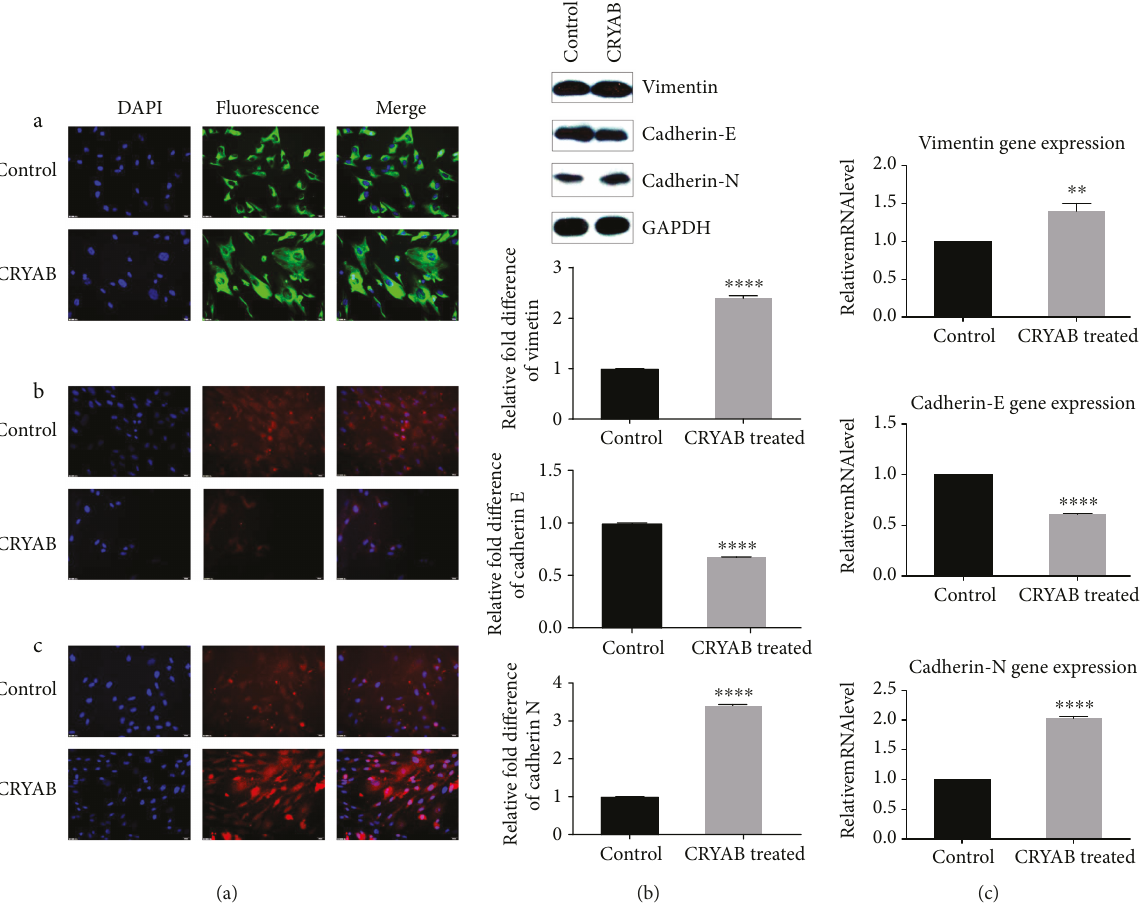
Figure 5: E ff ect of CRYAB on EMT in TM cells. (a) Immuno fl uorescence manifestation of vimentin, cadherin-E, and cadherin-N. Immuno fl uorescence veri fi ed the upregulation of vimentin and cadherin-N and the downregulation of cadherin-E (A: vimentin; B: cadherin-E; C: cadherin-N). (b) Western blot analysis of vimentin, cadherin-E, and cadherin-N expression. TM cells were exposed to 10ng/ml CRYAB for 24h. The expression of vimentin and cadherin-N increased, whereas cadherin-E decreased under CRYAB conditions compared with the control. (c) Real-time PCR analysis of vimentin, cadherin-E, and cadherin-N mRNA expression. Compared with the control, the expression of vimentin and cadherin-N was upregulated, while cadherin-E was downregulated in response to CRYAB. The data shown represent the mean ± SD of three independent experiments. ∗∗ p < 0 01 and ∗∗∗∗ p < 0 0001 versus the